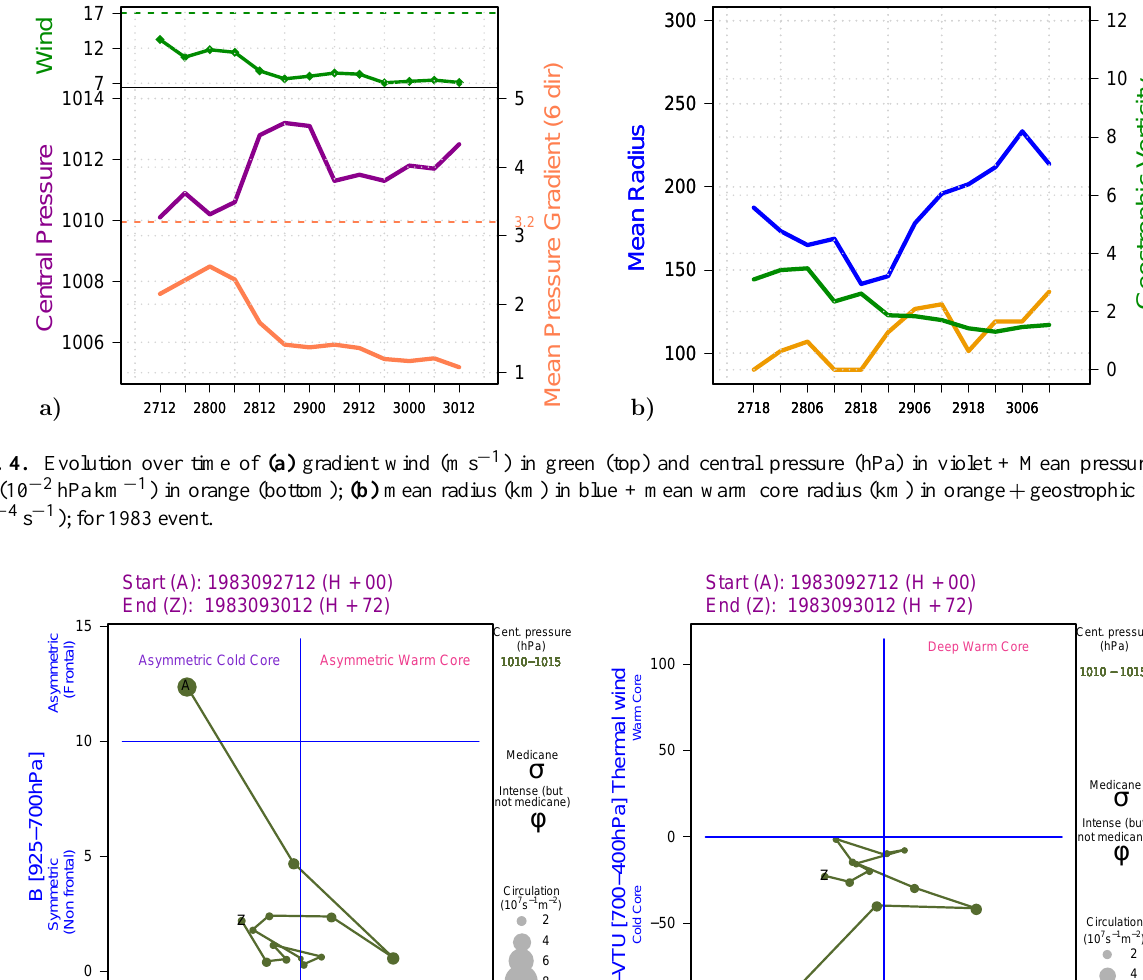
observed over Sicily at 12:00 UTC on 14 January. A surface low pressure system (called parent low) was evident over the sea west of Greece in MSLP maps, with winds of 22 and 29 m s − 1 and a pressure of 992.5 hPa reported by